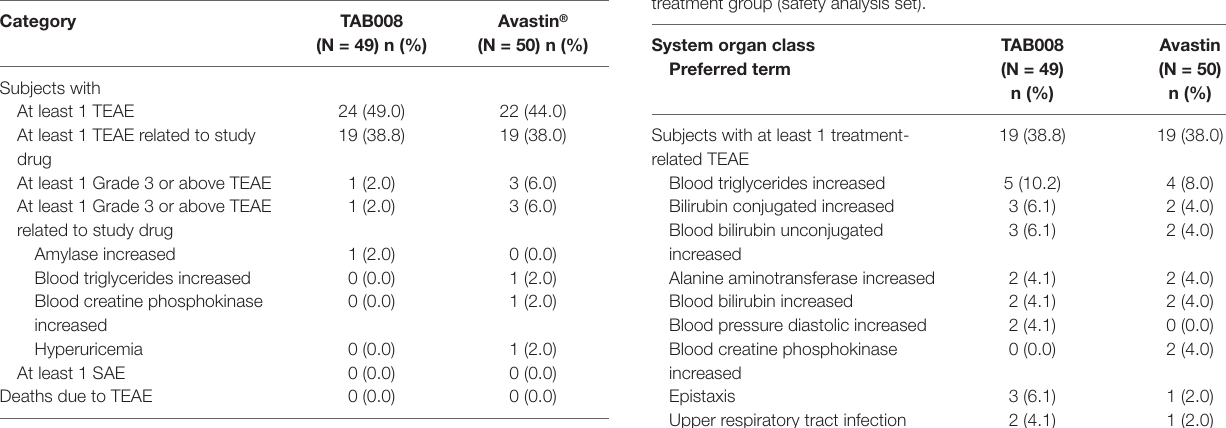
TABLE 3 | Summary of all treatment-emergent adverse events; grade 3 AE